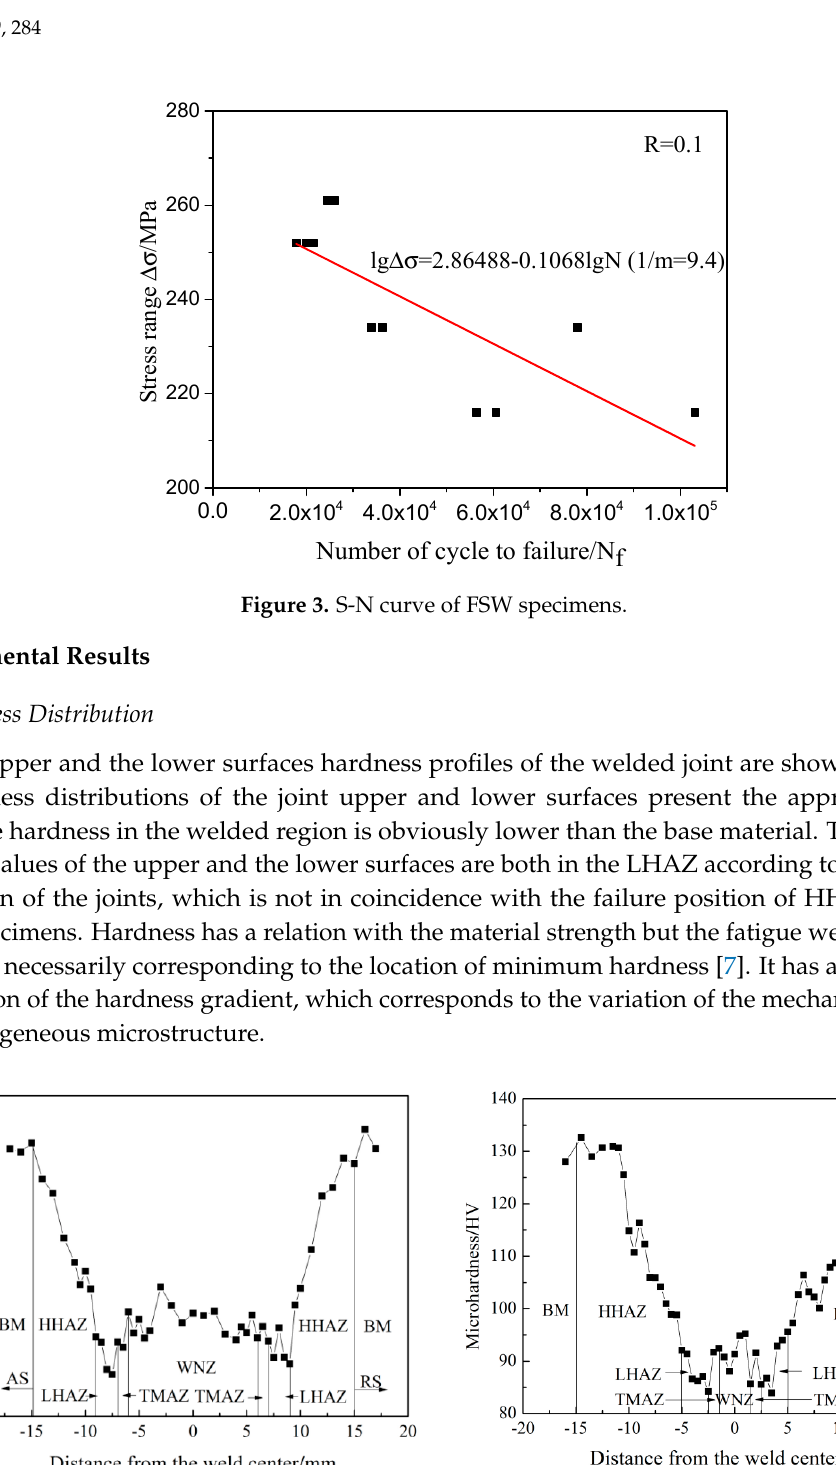
Figure 3. S-N curve of FSW specimens.